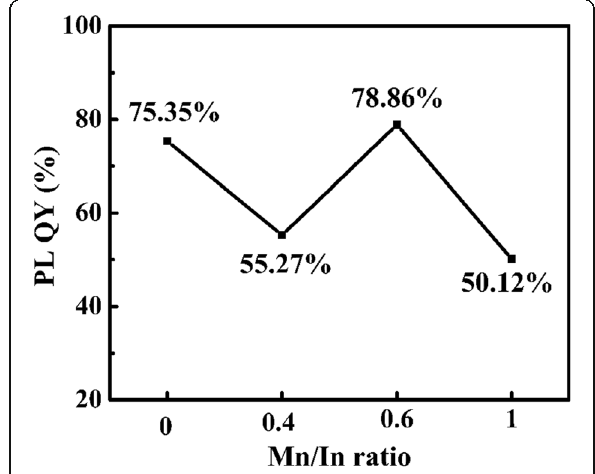
Fig. 5 The absolute PL QY of Mn:InP/ZnS QDs with different Mn/In